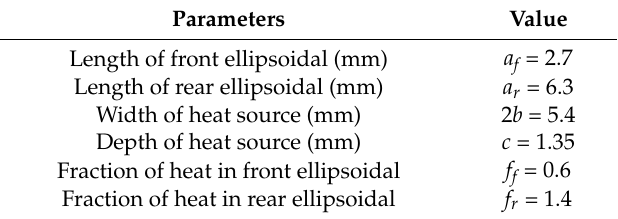
Table 4. Heat source parameters: I en / I ep = 240/120 A, f = 5 Hz, and u = 6